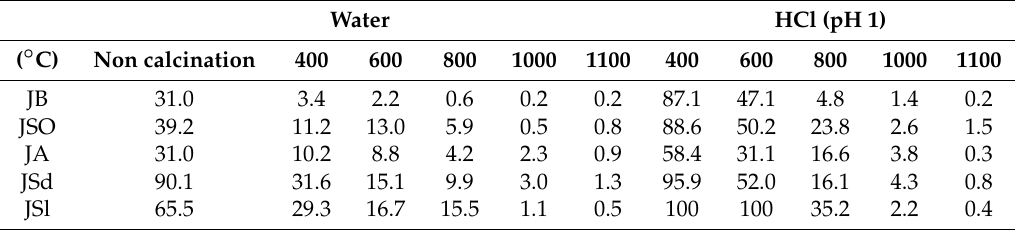
Table 3. Desorption ratio (wt %) of Cs + from the rocks (0.5 g) calcined at various temperatures, as calculated based on the Cs + adsorption quantities t without calcination (Figure